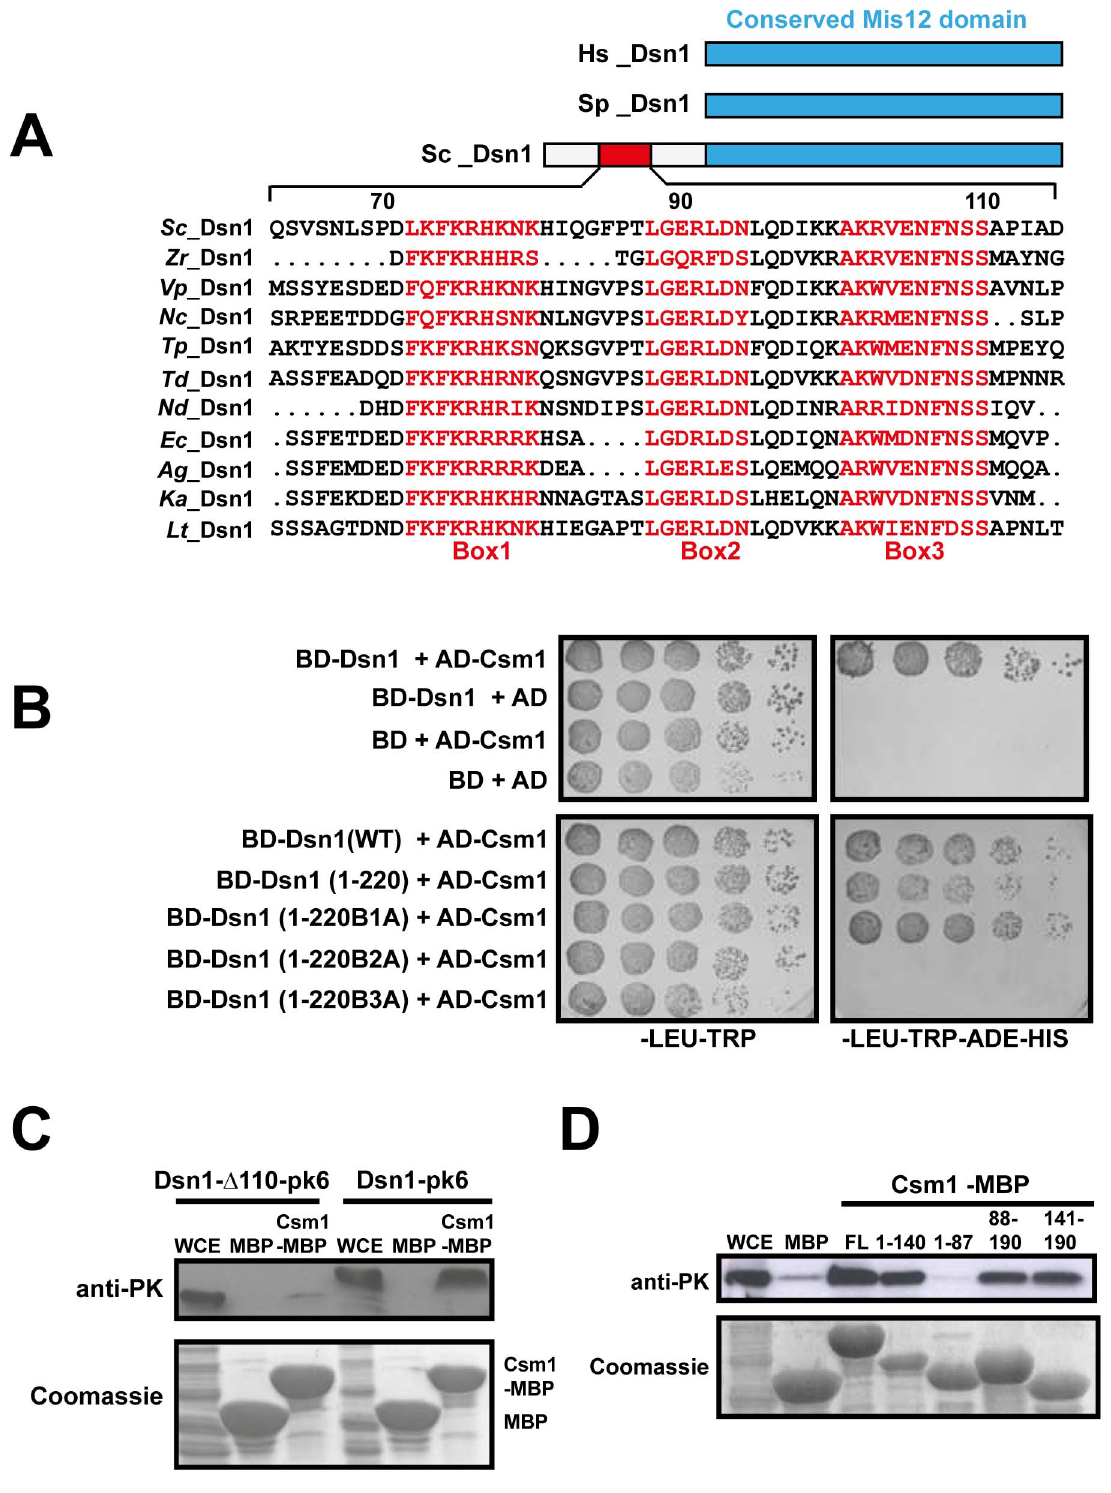
Figure 2. Csm1 interacts with the N-terminal domain of Dsn1. A) Multiple alignment of the amino acid sequences of the N-terminus of Dsn1 from several members of Saccharomycetes class of yeasts ( Sc - Saccharomyces cerevisiae ; Zr - Zygosaccharomyces rouxii ; Vp - Vanderwaltozyma polyspora ; Nc - Naumovozyma Castelli ; Tp - Tetrapisispora phaffia ; Nd - Naumovozyma dairenensi; Ec - Eremothecium cymbala ; Td - Torulaspora delbrueckii ; Ag - Ashbya gossypii ; Lt - Lachancea thermotolerans ; Ka - Kazachatania africana ). Three conserved elements are highlighted (Boxes 1–3). Note that the N-terminal domain is absent in Dsn1 homologs of S. pombe and humans. B) Dsn1 interacts with Csm1 in the 2-hybrid assay (Top panel). Transformants of AH109 strain containing pGBKT7-Dsn1 + pGAD-Csm1 or pGBKT7 + pGAD-Csm1 or pGBKT7-Dsn1 + pGAD or pGBKT7 + pGAD were spotted at different dilutions on non-selective SD-LEU-TRP plates and selective SD-LEU-TRP-ADE-HIS plates. Growth was monitored after incubation at 30 u C for 2–3 days. Boxes 2 and 3 but not Box 1 in Dsn1 is required for interaction with Csm1 (Bottom panel). Transformants of AH109 strain containing pGBKT7-Dsn1 +